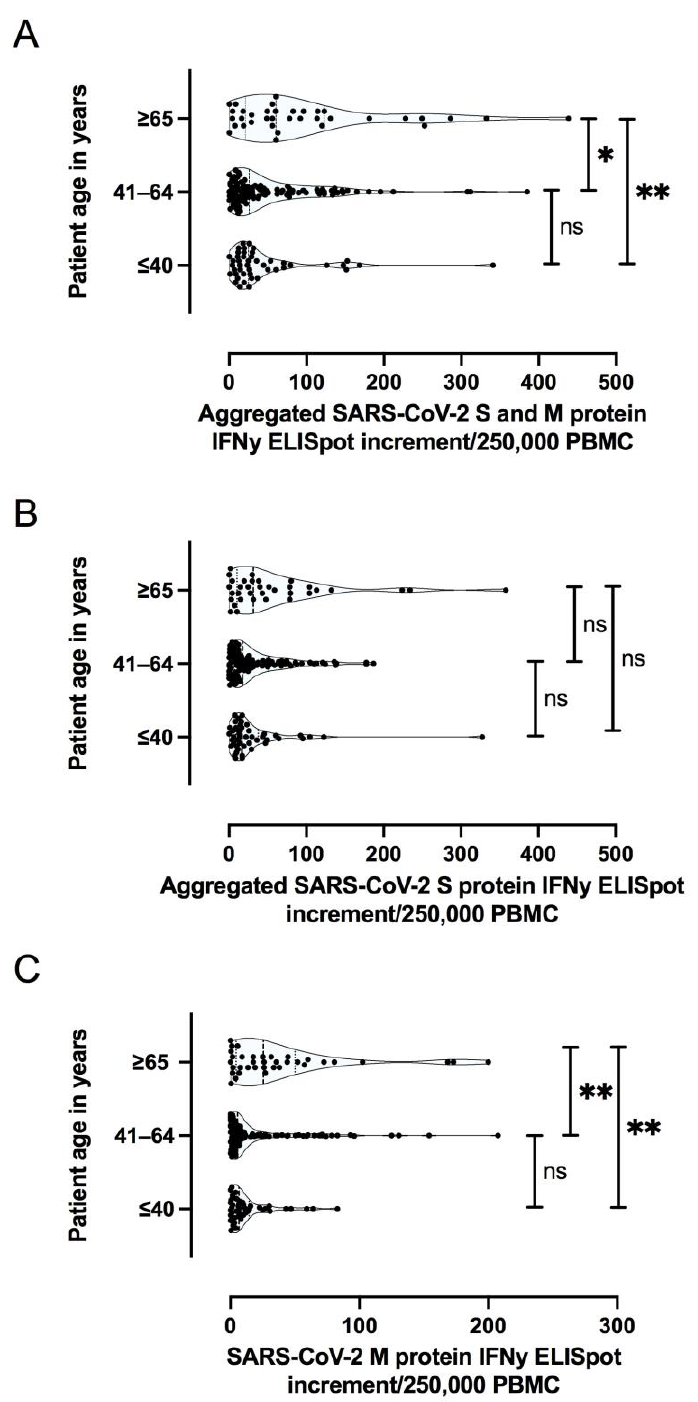
Figure 6. Aggregated IFNy ELISpot increment for SARS-CoV-2 Spike (S) and Membrane (M) protein specific T cell responses ( A ), aggregated number of S protein specific T cell responses ( B ), and M protein specific T cell responses ( C ), with respect to patient age. ** p < 0.005; * p < 0.05; ns not significant.